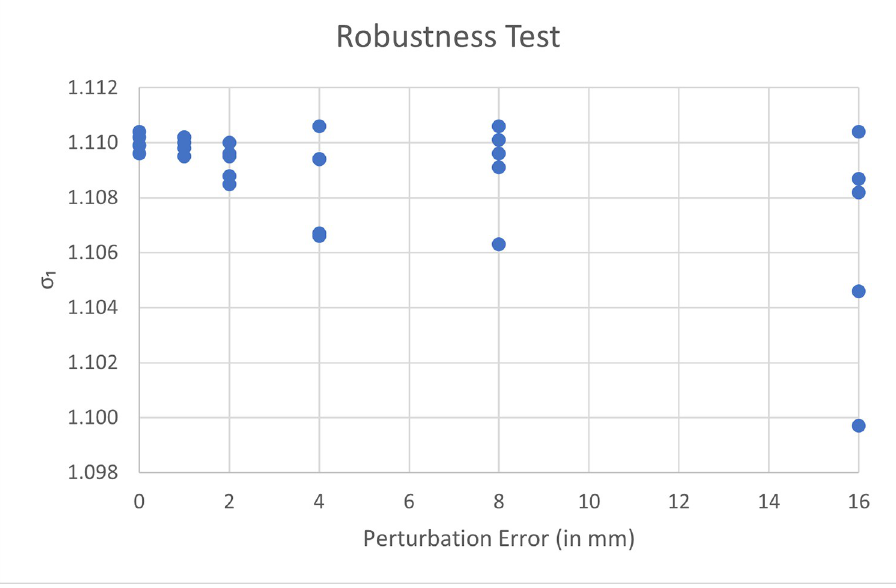
Fig 3. Expansion coefficient values extracted by repeated trials with increasing perturbation noise applied to the initial landmarks used for rough alignment. Note that, when no perturbation is applied, the final coefficients still differ slightly across trials due to the randomness of the ICP sampling scheme adopted by